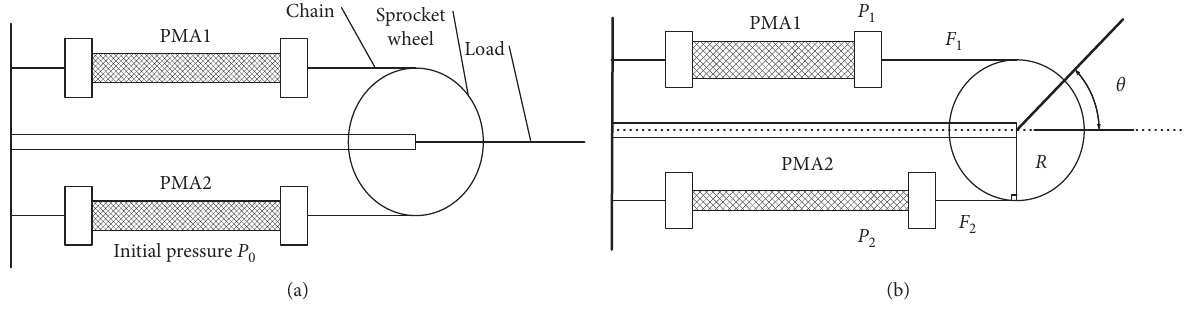
Figure 11: The principle of joint driven by